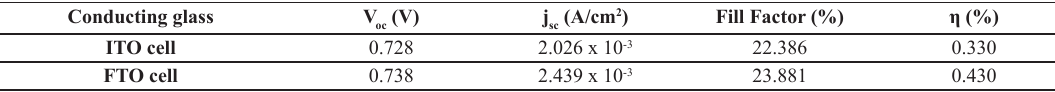
Table 2. j x V curve results of cells using pencil graphite as counter electrode. Counter electrode Sintered pencil